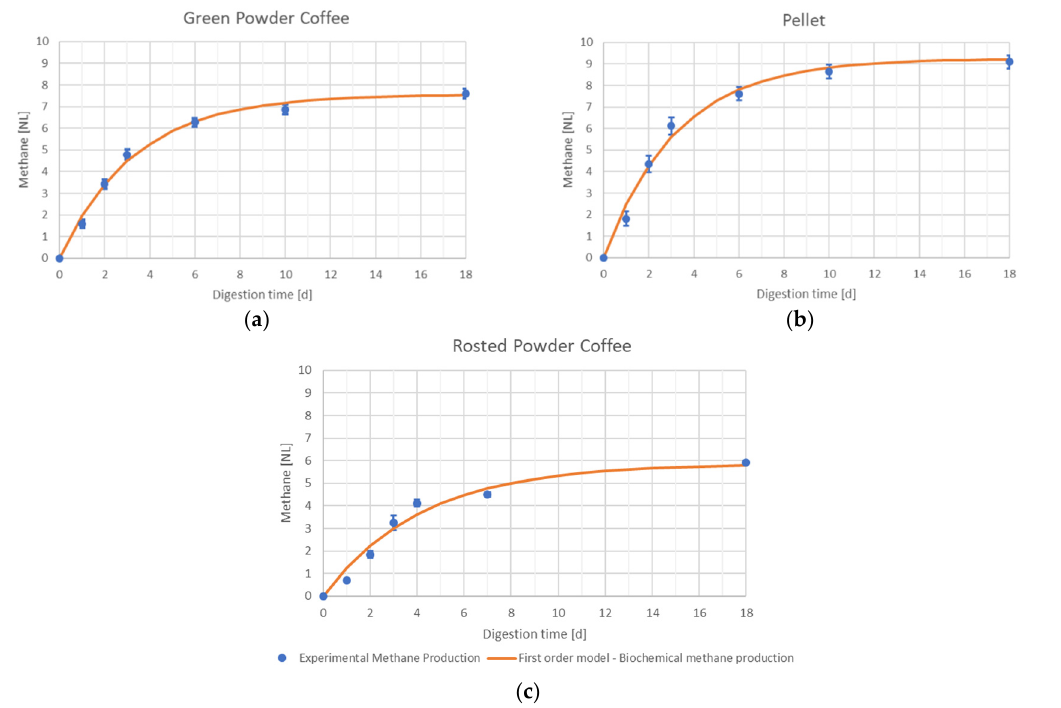
Figure 1. Anaerobic digestion (AD) batch tests. Measured points and simulated biochemical methane production curves. ( a ) green powder coffee; ( b ) pellet; ( c ) rosted powder coffee.